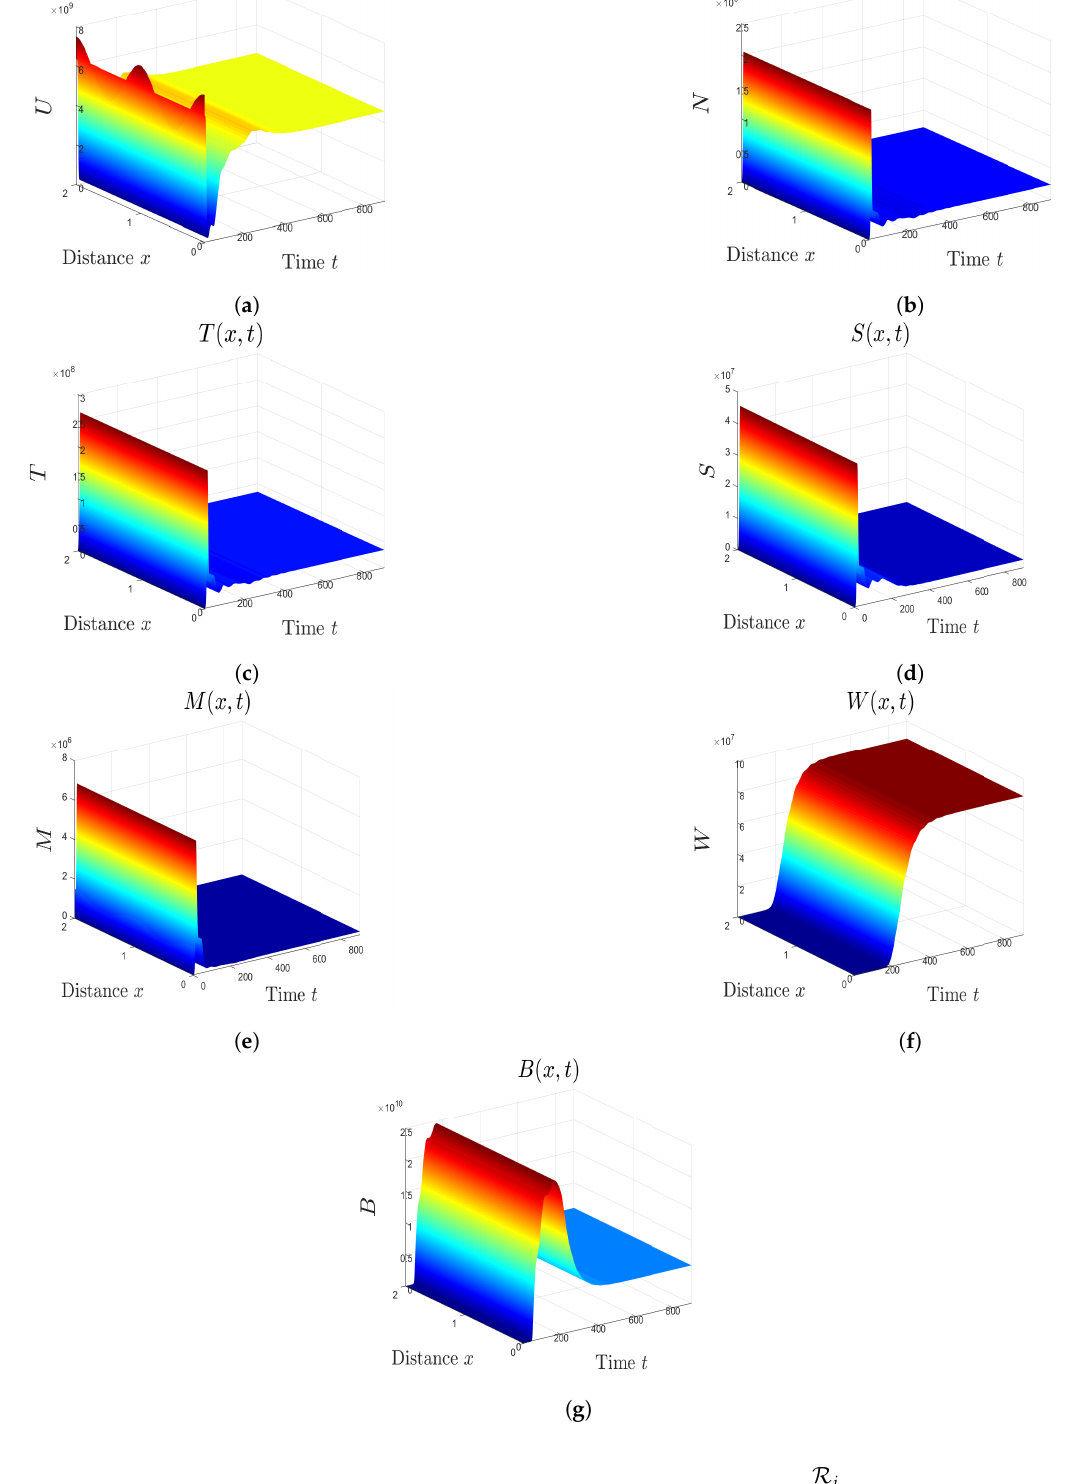
Figure 5. The numerical simulations of model (3) when R l > 1 and equilibrium E 4 is globally asymptotically stable. The subfigures show the spatiotemporal behaviors of ( a ) uninfected red blood cells U , ( b ) ring infected red blood cells N , ( c ) trophozoite infected red blood cells T , ( d ) schizont infected red blood cells S , ( e ) free merozoites M , ( f ) CTLs W , and ( g ) antibodies B